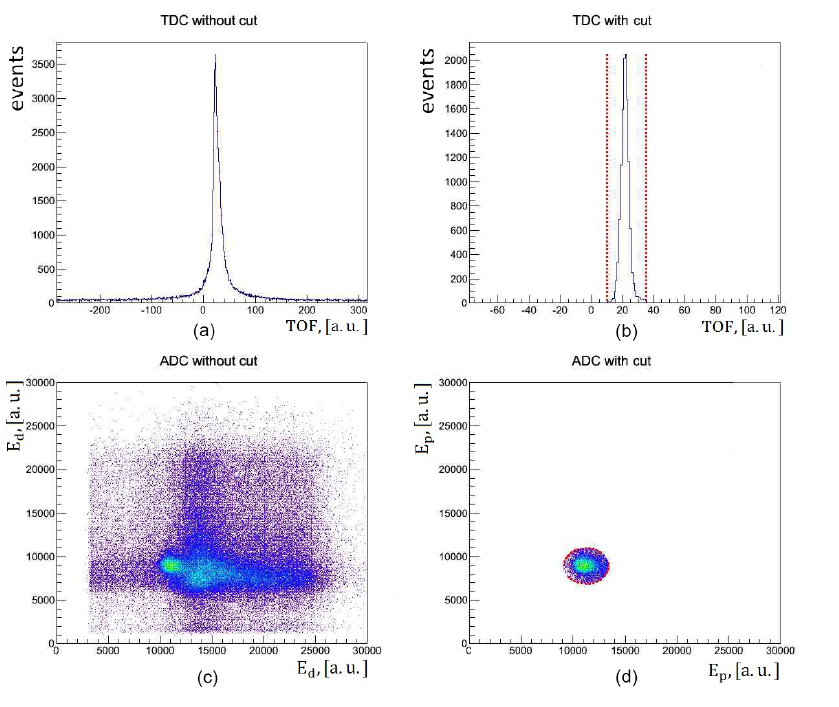
Figure 1. Selection of the dp elastic events by the time-of-flight di ff erence (TOF) and the correlation of the energy-losses signals for a pair of the deuteron and proton detectors at 95 ◦ in the center-of-mass system. a) and c) (b) and d)) panels show the TDC and ADC spectra without (with) graphical